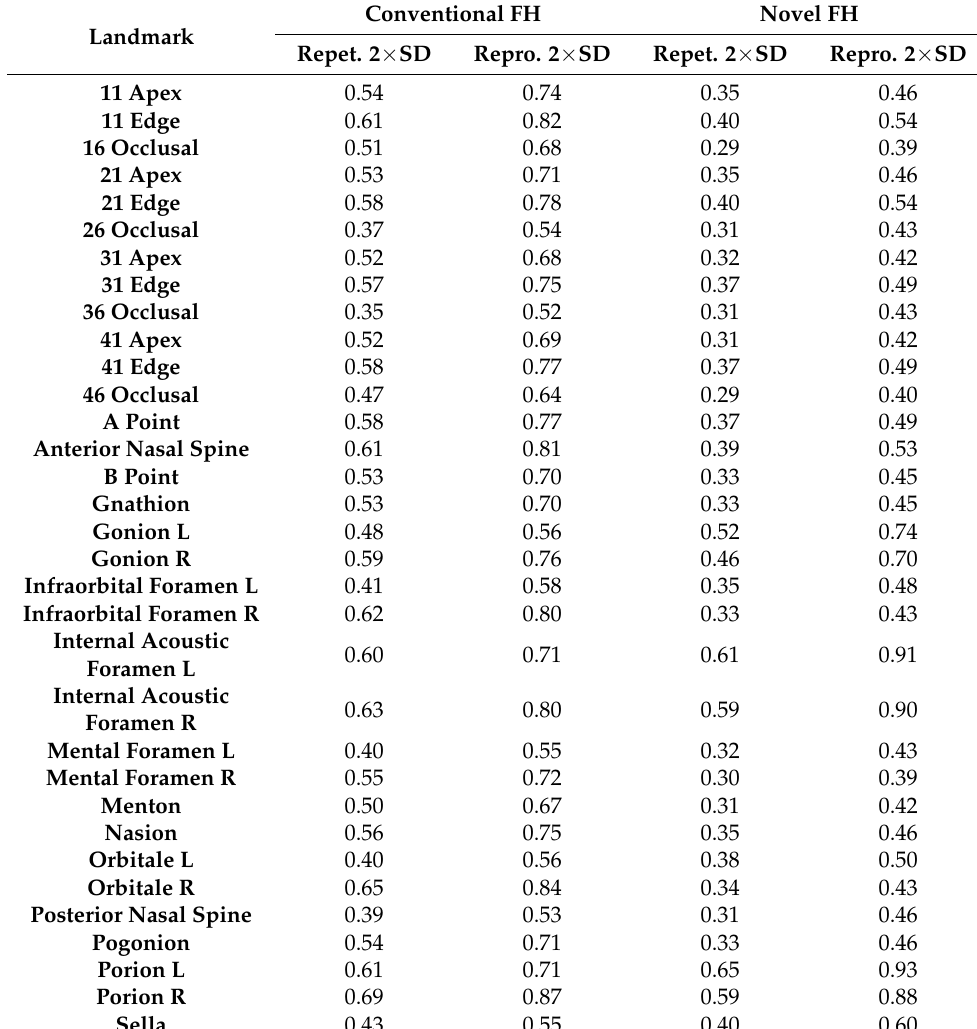
Table 5. 95% confidence interval (2 × SD) of repeatability and reproducibility of the vertical measure- ments of the landmarks (mm) using 2 FH planes as horizontal references, following the ISO 5725